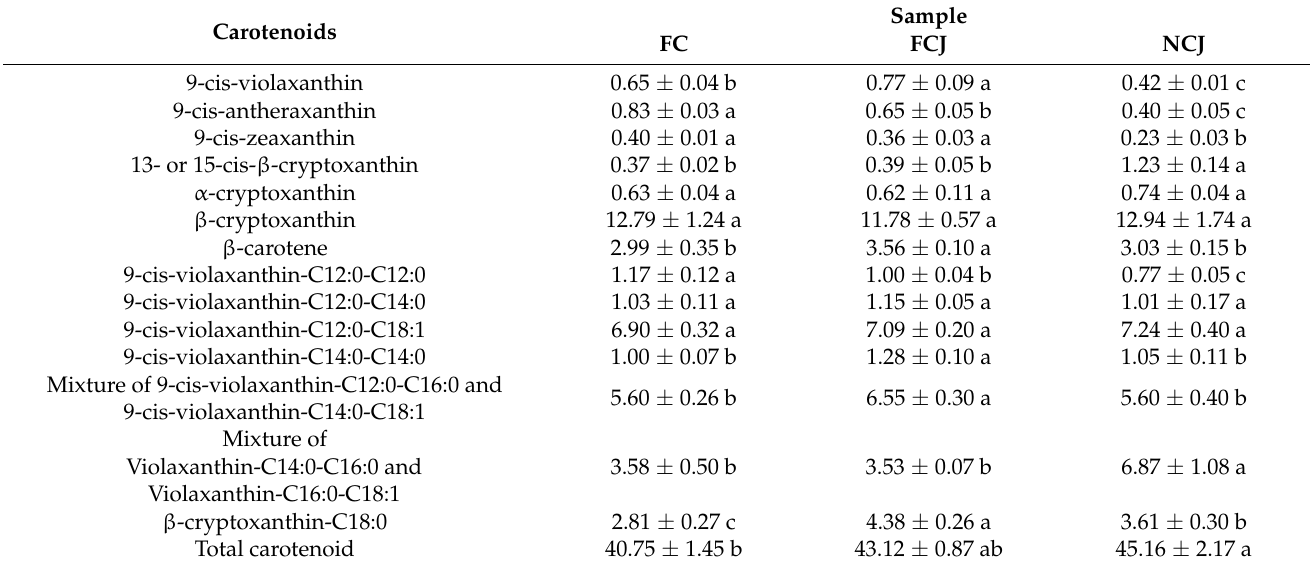
Table 1. Carotenoid contents of fresh citrus (FC), fresh citrus juice (FCJ), and not-from-concentrate citrus juice (NCJ) ( µ